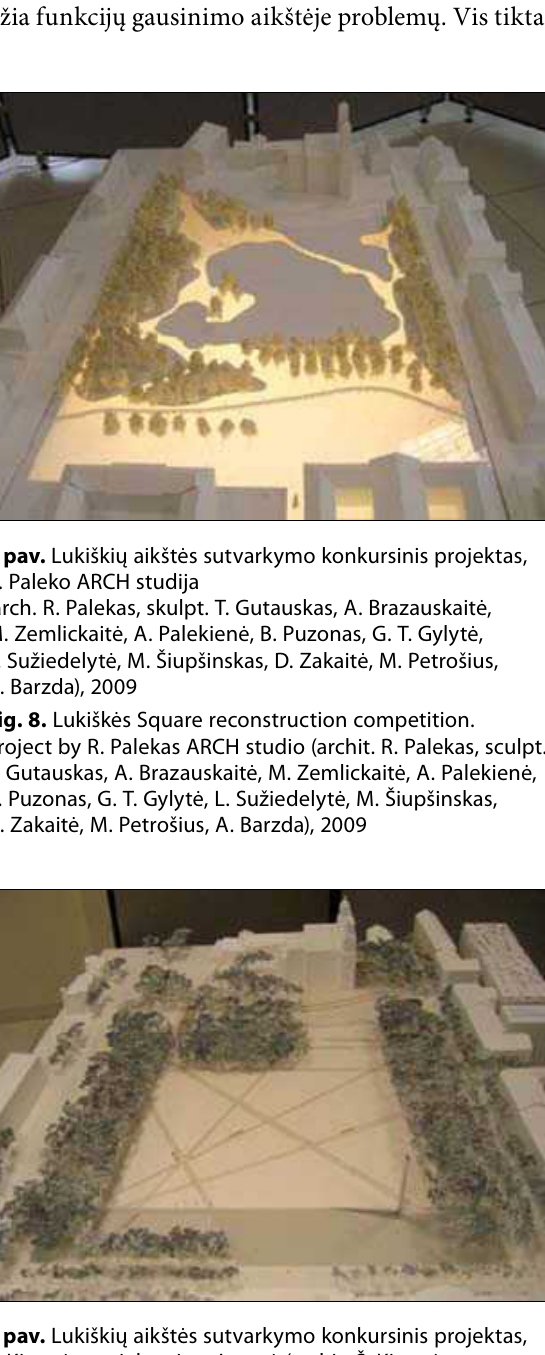
Fig. 9. Lukiškės Square reconstruction competition. Project